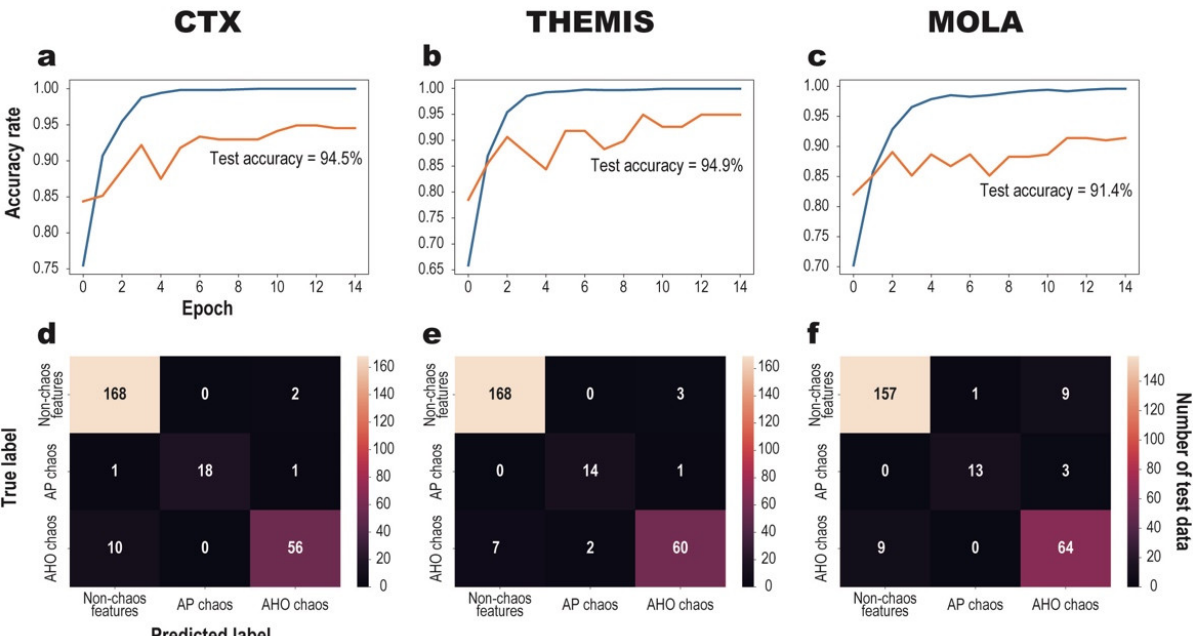
Figure 6. Typical results of learning curves and confusion matrices for CTX, THEMIS, and MOLA classifiers for 4 Division training data and a batch size of 64. Panels ( a – c ) are learning curves pertaining to the CTX, THEMIS, and MOLA classifiers, respectively, for 15 epochs of learning. Calculated test and training accuracies are shown as orange and blue lines, respectively. Panels ( d – f ) are the confusion matrices associated with the CTX, THEMIS, and MOLA classifiers, respectively. Colors and numbers in the confusion matrices represent the test accuracy and the numbers of classified images, respectively, for 15 epochs of learning.